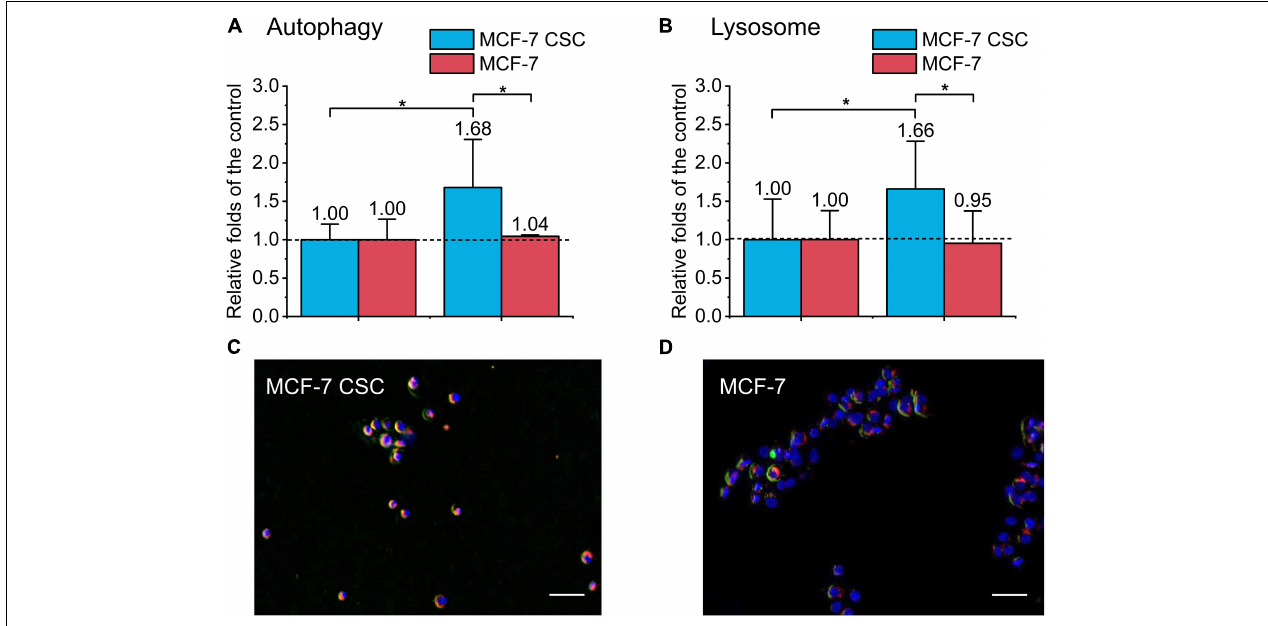
FIGURE 5 | Detection of autophagy and lysosome of irradiated MCF-7 cells and MCF-7 CSCs. (A) Compared with the control, the increasement of autophagy proportion for irradiated group. (B) Compared with the control, the increasement of lysosome for irradiated group. (C,D) Representative images of irradiated MCF-7 cells and MCF-7 CSCs stained with MDC autophagy detection kit and lysoTracker Red DND-99. The blue was the nucleus, the red was the lysosome, and the green labeled autophagy. Scale bars: 50 µ m. * P <